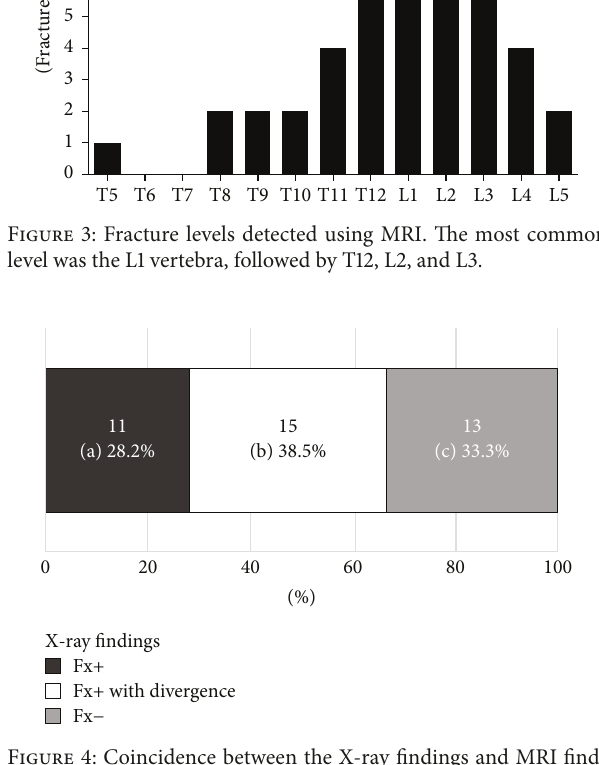
Figure 4: Coincidence between the X-ray findings and MRI find- ings. Among the cases with fractures confirmed using MRI, 28.2% ((a) 11/39) showed a positive fracture finding both on X-ray and on MRI, while 38.5% ((b) 15/39) showed divergence between these two radiological modalities. The remaining 13 cases ((c) 33.3%) showed a positive MRI finding with a negative X-ray finding, suggesting a true occult fracture (no deformity or fracture in the plain X-ray with positive MRI